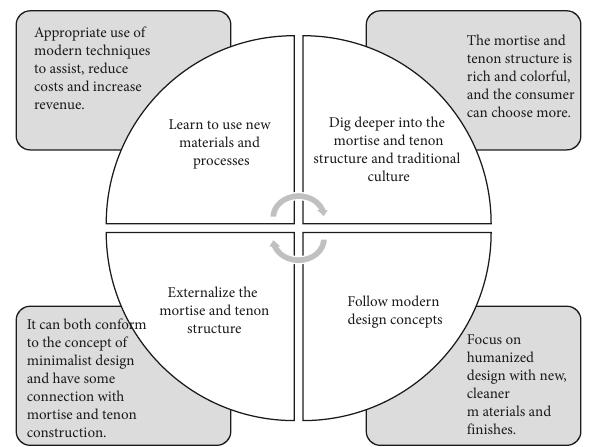
Figure 5: Tenon and tenon structure is used in the method of modern home